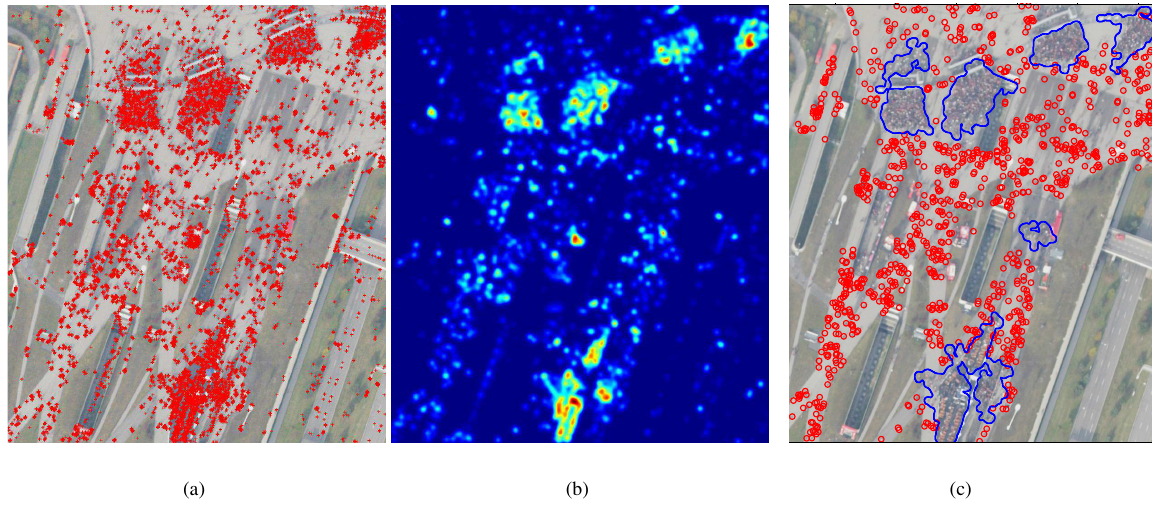
Figure 2: (a) Detected FAST feature locations on Stadium 1 test image are represented with red crosses, (b) Estimated probability density function (color coded) for Stadium 1 image generated using FAST feature locations as observations, (c) Automatically detected dense crowd boundaries and detected people in sparse groups for Stadium 1